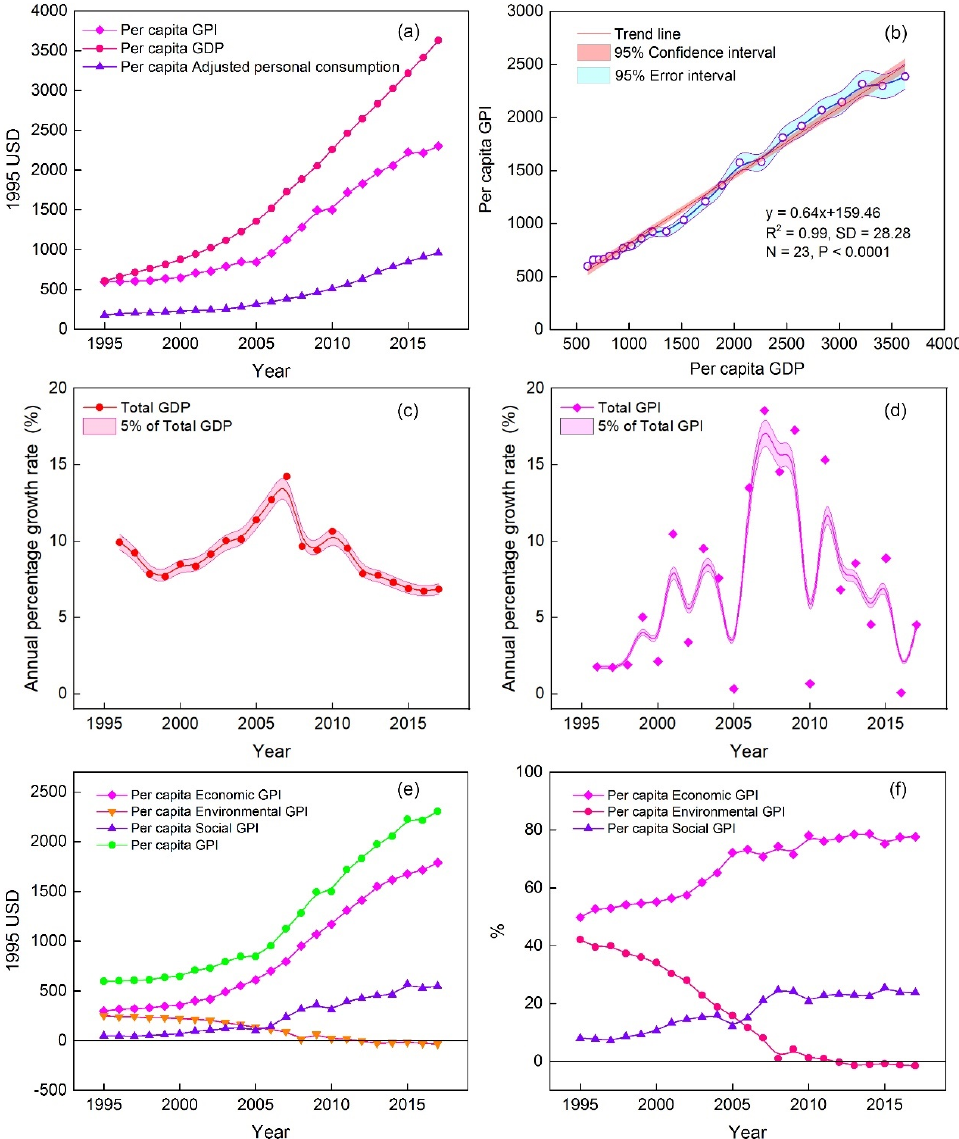
Figure 2. Characteristics of interannual evolution of GPI and GPI in China from 1995 to 2017: changes in per capita GPI and GDP ( a ); relative threshold effect detection ( b ); growth rate changes in total GPD and GPI ( c , d ); changes in per capita GPI for economic, environmental, and social components and their contributions to per capita GPI ( e , f ).